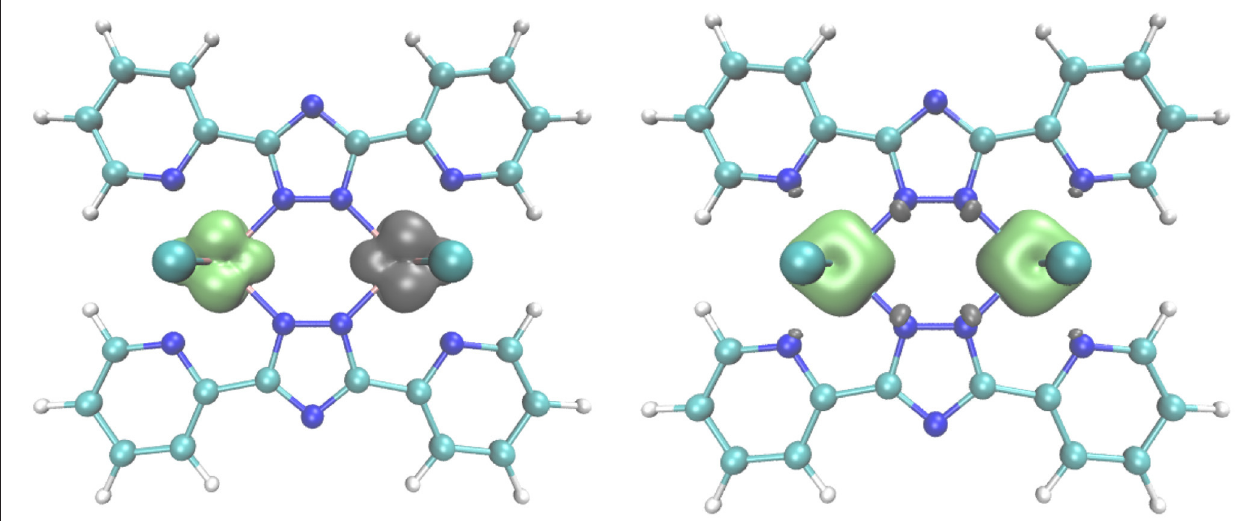
FIGURE 9 | Spin density plots for the the broken symmetry state of the antiferromagnetically coupled vanadium compound (1) (left), and the high spin state (S = 3) of the ferromagnetically coupled chromium compound (2) (right), obtained with the B3-LYP functional and TZVPP basis set. Contour value for the spin density is 0.008.